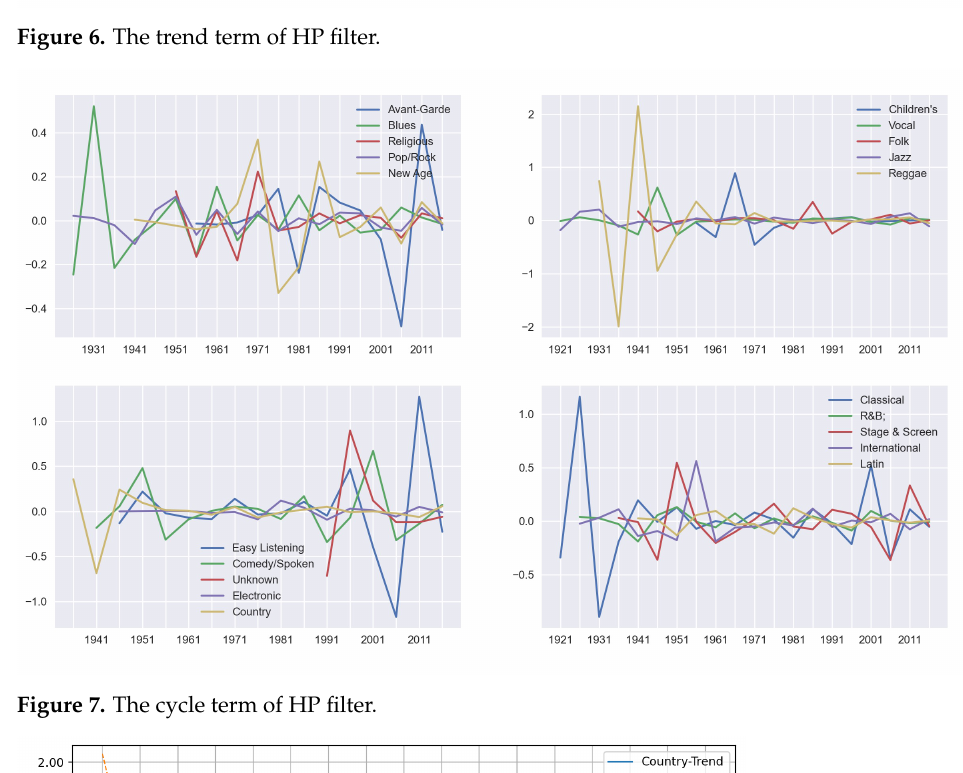
Figure 6. The trend term of HP filter.